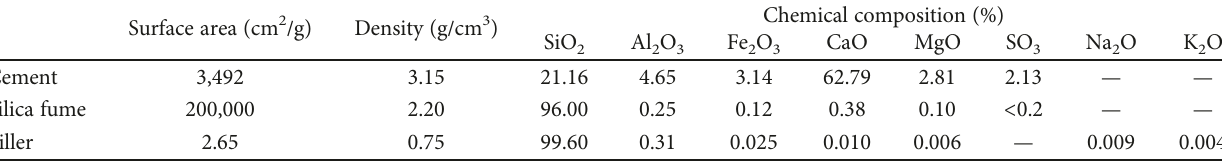
Table 3: Chemical compositions and physical properties of cementitious materials.